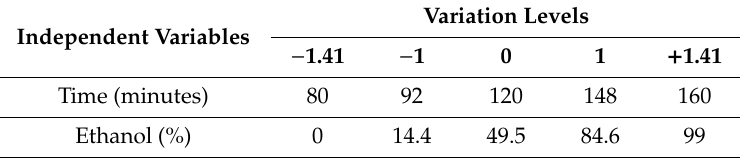
Table 1. Variation ranges for preparing rosemary-of-field extracts using an experimental design. Variation Independent Variables